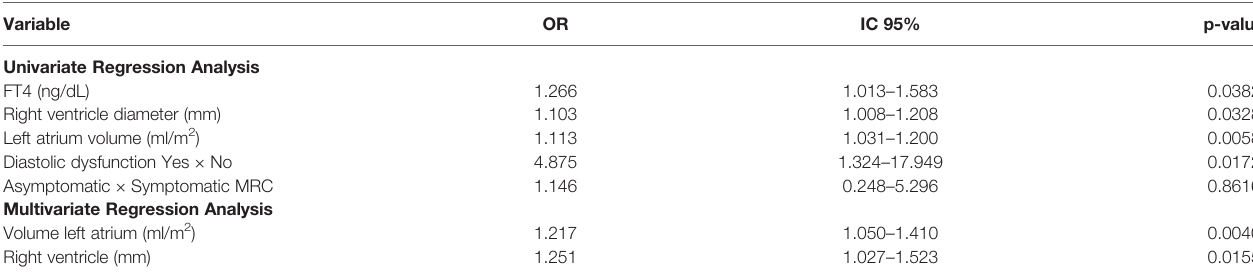
TABLE 5 | Demographic, laboratory factors of cardiorespiratory assessment associated with pulmonary hypertension in patients with Graves' disease. Variable